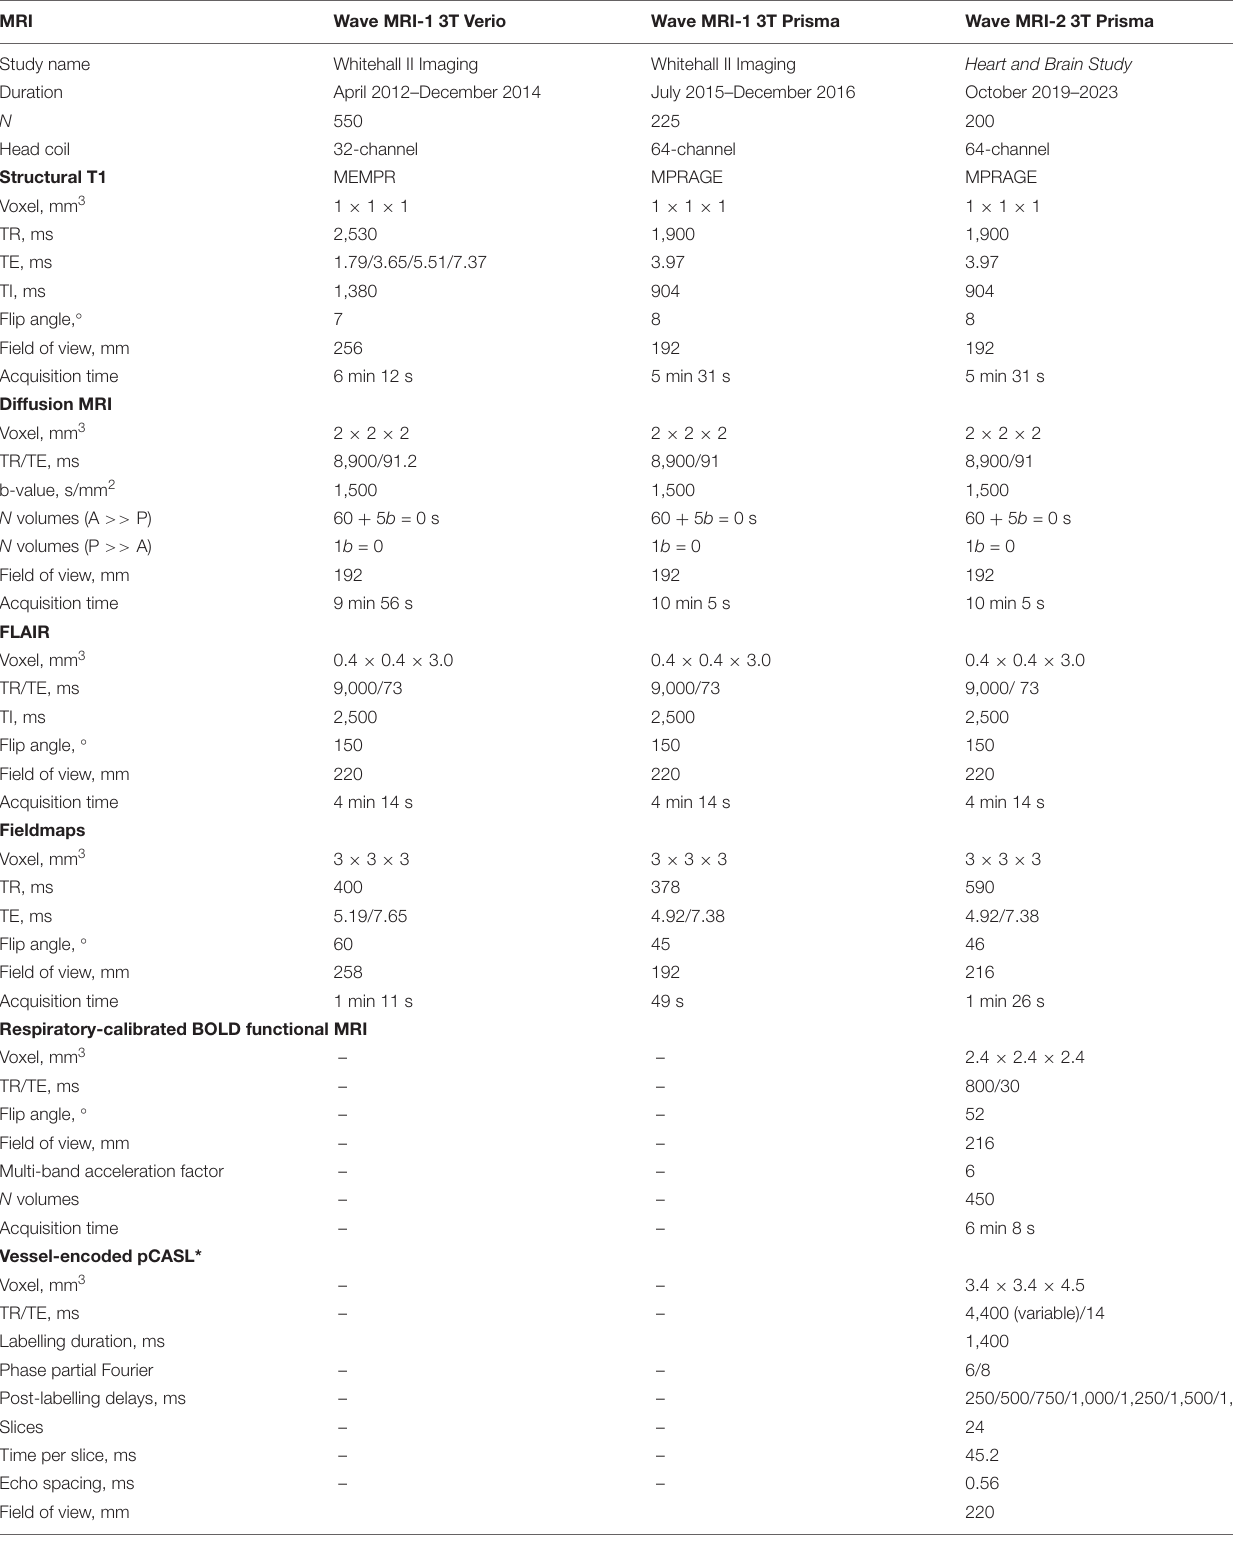
TABLE 2 | Acquisition parameters of the core MRI sequences at Waves MRI-1 and MRI-2.